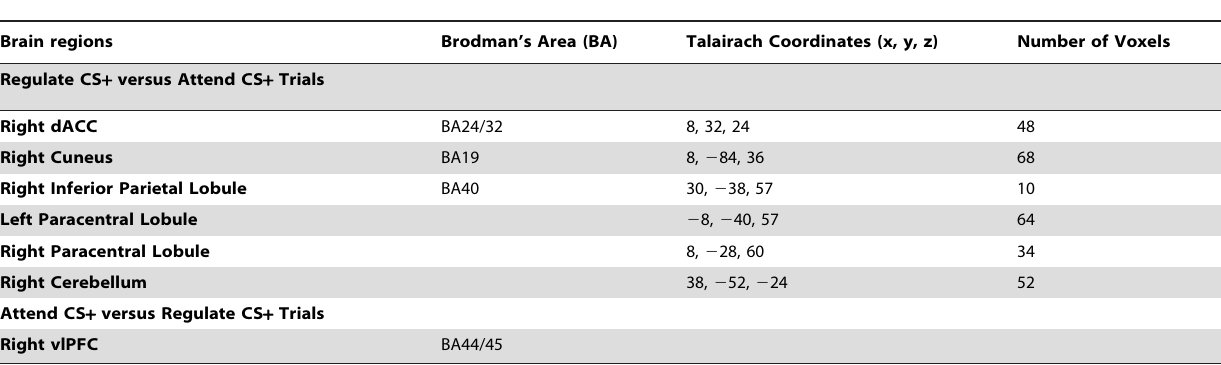
Table 1. Regions activated by a contrast of Attend CS + versus Regulate CS + and vice versa (p , 0.001).